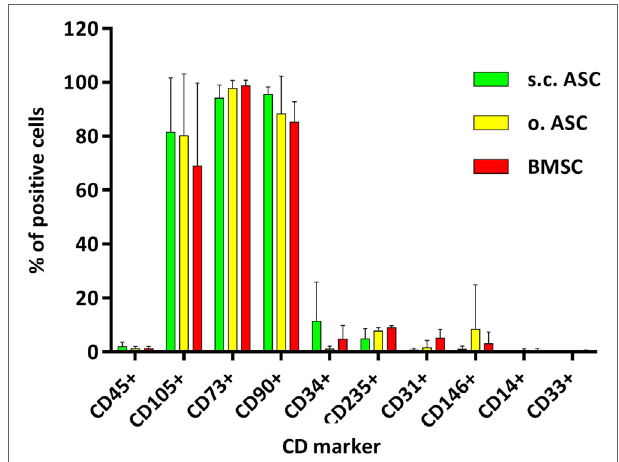
FigUre 1 | Flow cytometric analysis of mesenchymal stem cell (MSC) deriving from s.c. adipose tissue (s.c.ASC), omentum (o.ASC), and bone marrow-derived mesenchymal stem cell (BMSC). Cells isolated from four individual donors for each cell type were pooled ( n = 4). MSCs were positive for CD105, CD73, and CD90 and clearly negative for CD 45, CD31, CD145, CD114, and CD 33. Slight differences were seen in the markers CD34 and CD146 which did not reach significance. Slight differences were noted between individual donors but showed a similar surface pattern for all